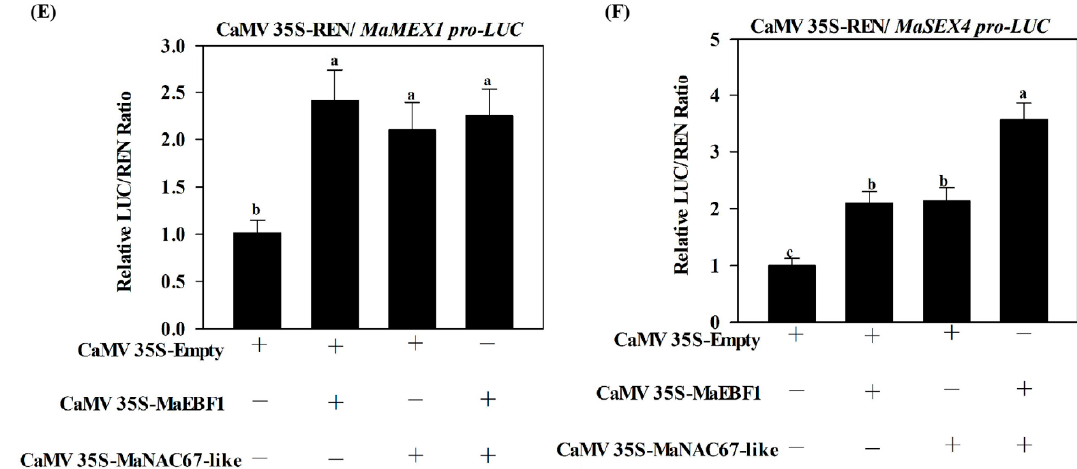
Figure 5. Transcriptional activation of starch degradation genes by MaEBF1 and MaNAC67-like in the transient expression system. The promoters of MaBAM6, MaMEX1, and MaSEX4 were ligated into a pGreenII 0800-LUC double-reporter vector ( A ), while MaNAC67-like was ligated into the pGreenII 62-SK vector as an e ff ector ( B ). The transcriptional activity of MaNAC67-like on the starch degradation-related gene promoter of MaBAM3 , MaBAM4 , MaBAM6 , MaBAM7 , MaBAM8 , MaPWD1 , MaGWD1 , MaAMY3 , MaISA2 , MaSEX4 , and MaMEX1 ( C ). The ratio of LUC to REN of the empty vector plus promoter vector was used as a calibrator (set as 1). ( D – F ) Transcriptional activity of MaEBF1, MaNAC67-like, and MaNAC67-like + MaEBF1 on the activities of promoter of MaBAM6 ( D ), MaMEX1 ( E ), and MaSEX4 ( F ). Each value was calculated from the means of six biological replicates. The values represent the means ± SE.